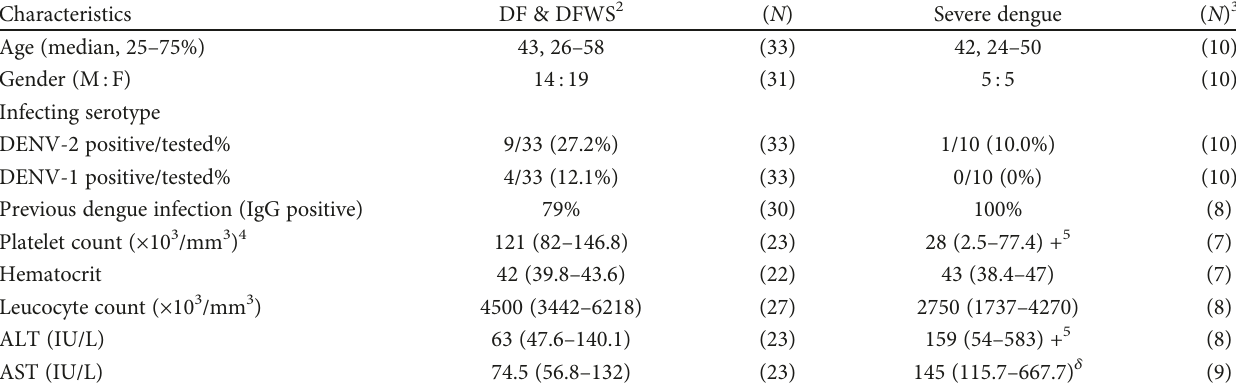
Table 1: Demographic, clinical, and laboratorial characteristics of DENV infected patients.